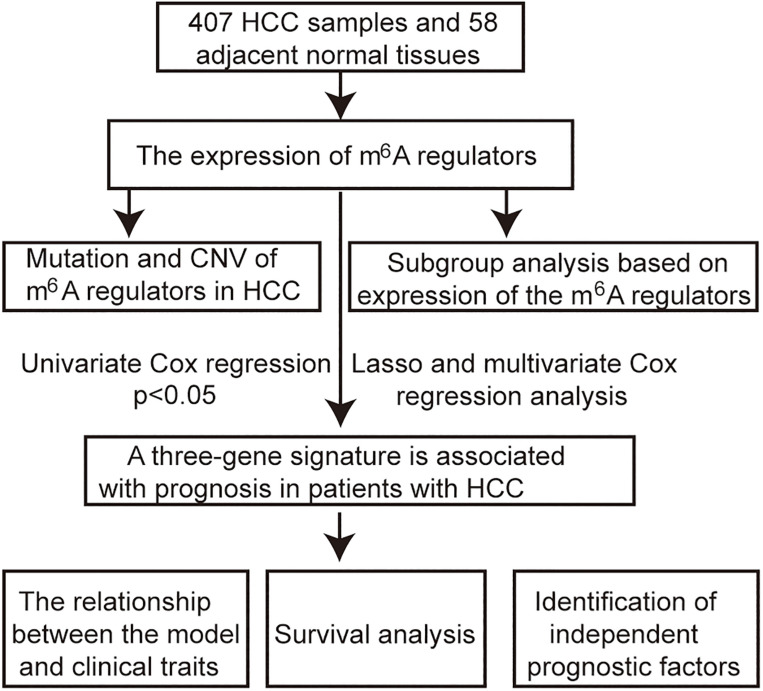
Flow chart of the approach utilized in the current study.